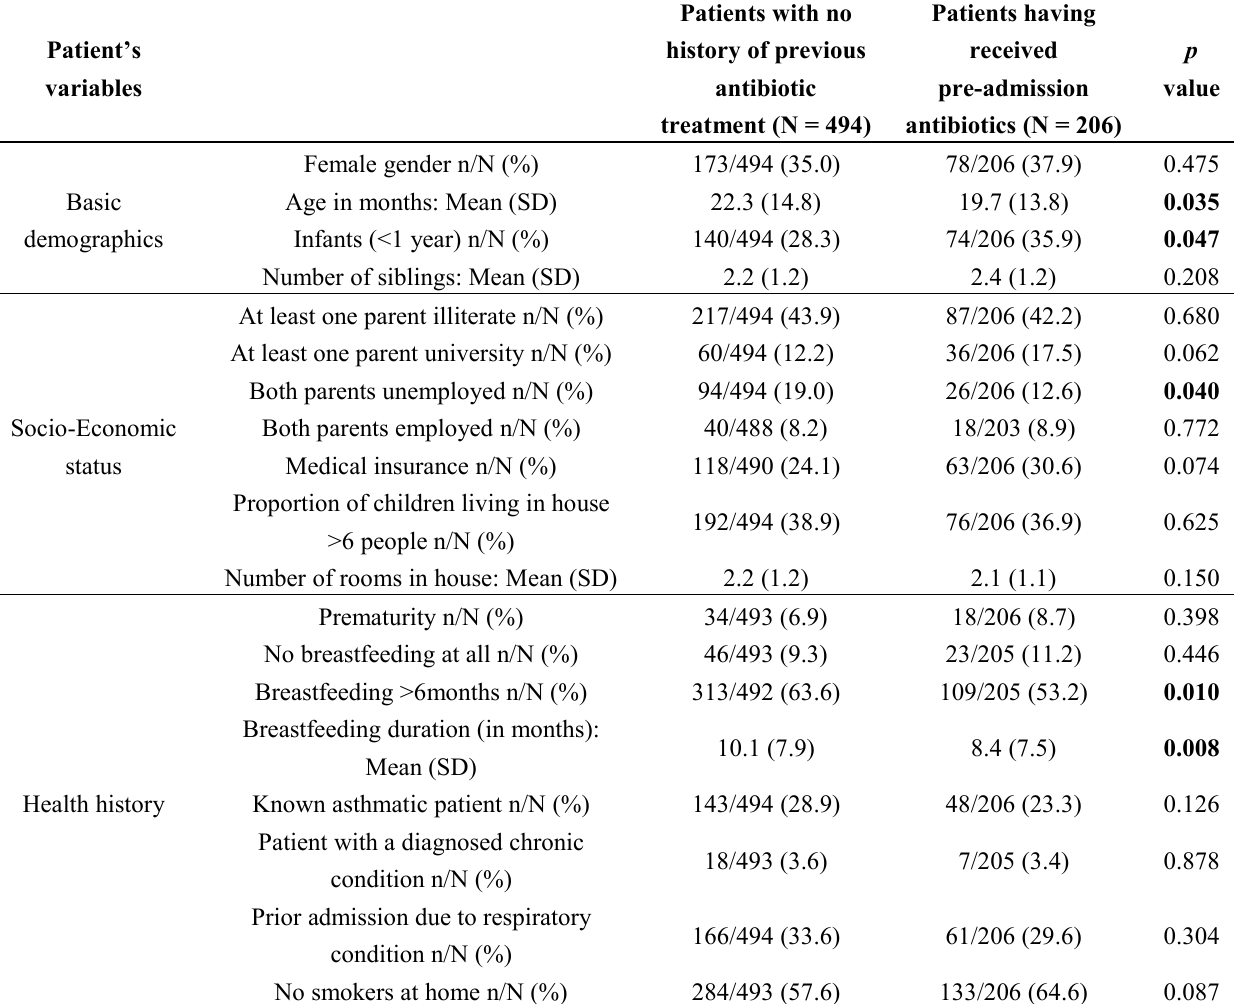
Table 1. Basic demographic, clinical, laboratory and outcome variables among patients recruited to the study according to prior antibiotic